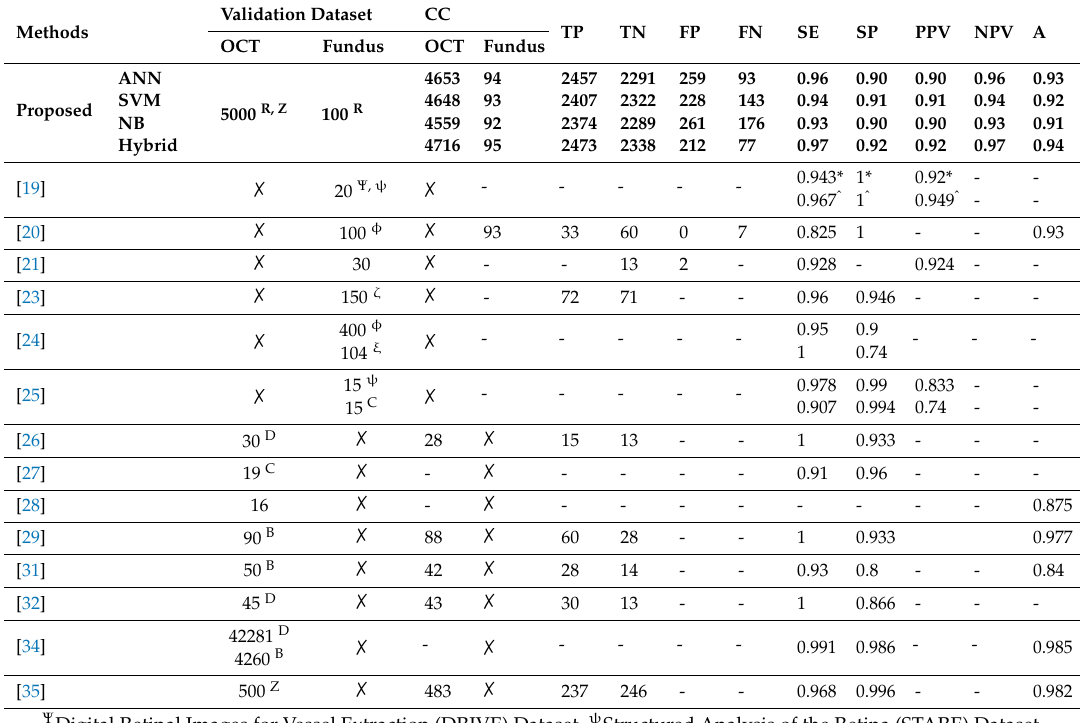
Table 9. Measure outcomes of the proposed ensemble hybrid classifier in comparison to other state-of-the-art techniques.